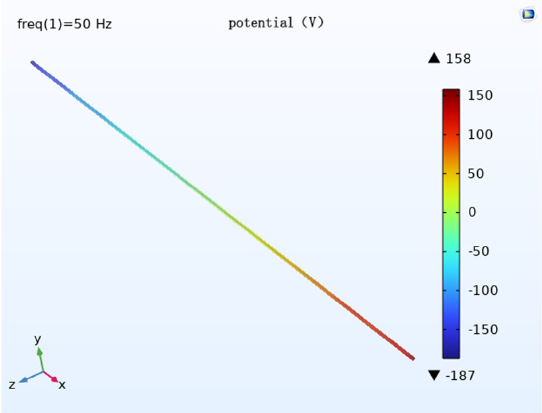
Figure 26. Distribution of cathodic protection potential at 4 m burial depth.